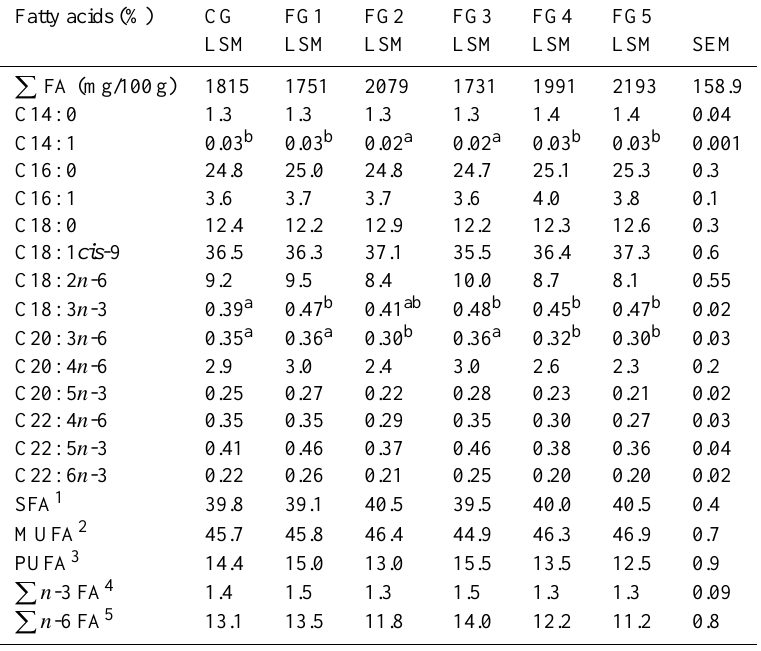
Table 5. Fatty acid profile (% of the total fatty acids) of longissimus muscle of pigs fed diets supplemented with sea buckthorn pomace. Fatty acids (%) CG FG1 FG2 FG3 P FA